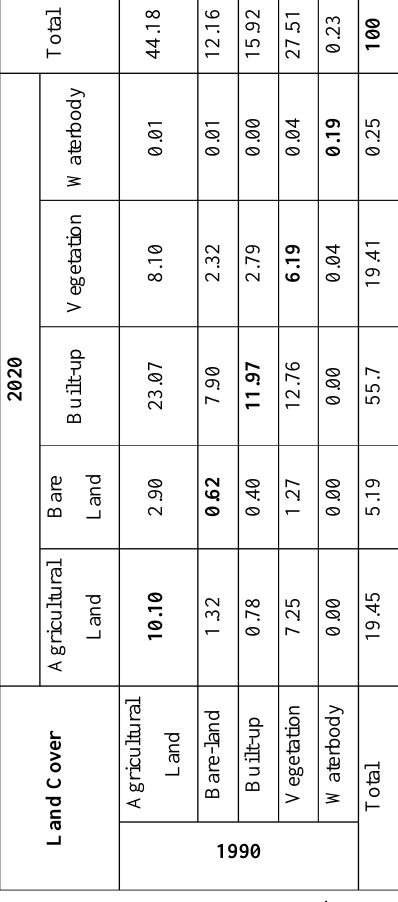
Table 4: Land cover transition matrix